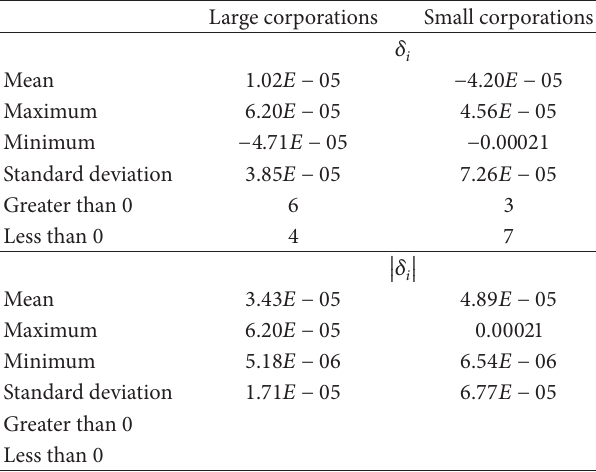
Table 6: The statistics of 𝛿 𝑖 estimated by Censored-SS model.